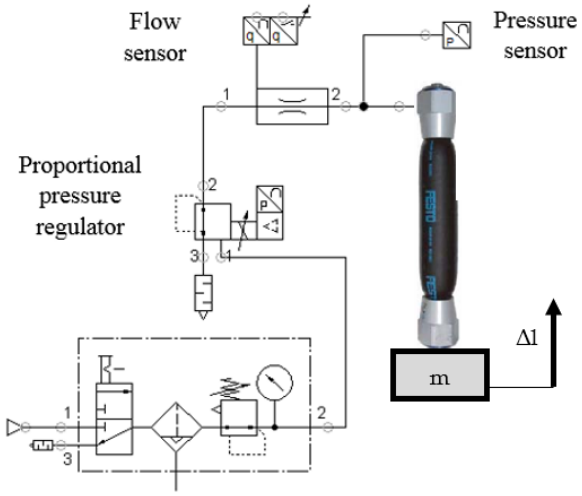
Figure 14. Supply pressure adjustment with a proportional pressure regulator.